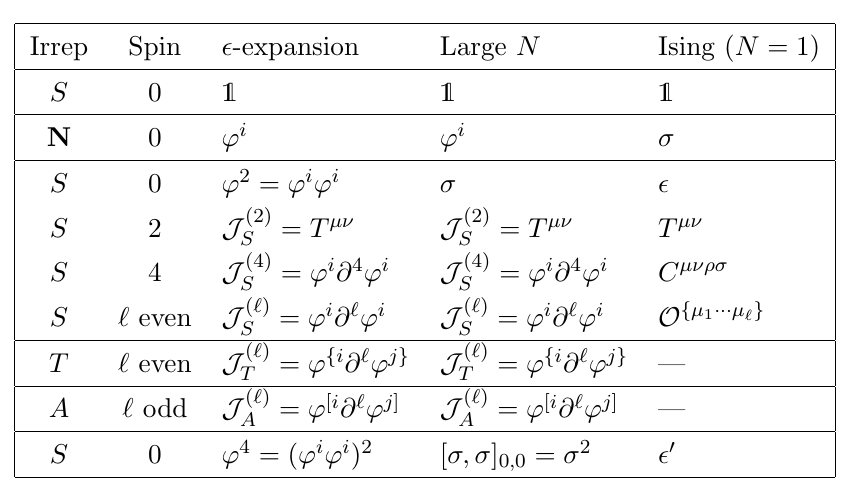
Figure 2 . The critical O( N ) model is de(cid:12)ned for 2 < d < 4 and N positive integer.